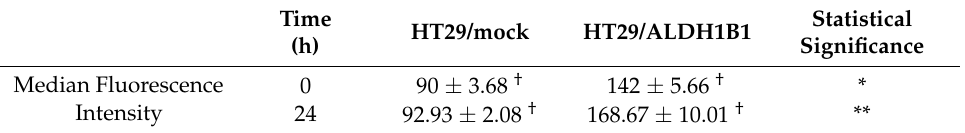
Table 4. Median fluorescence intensity for p21.